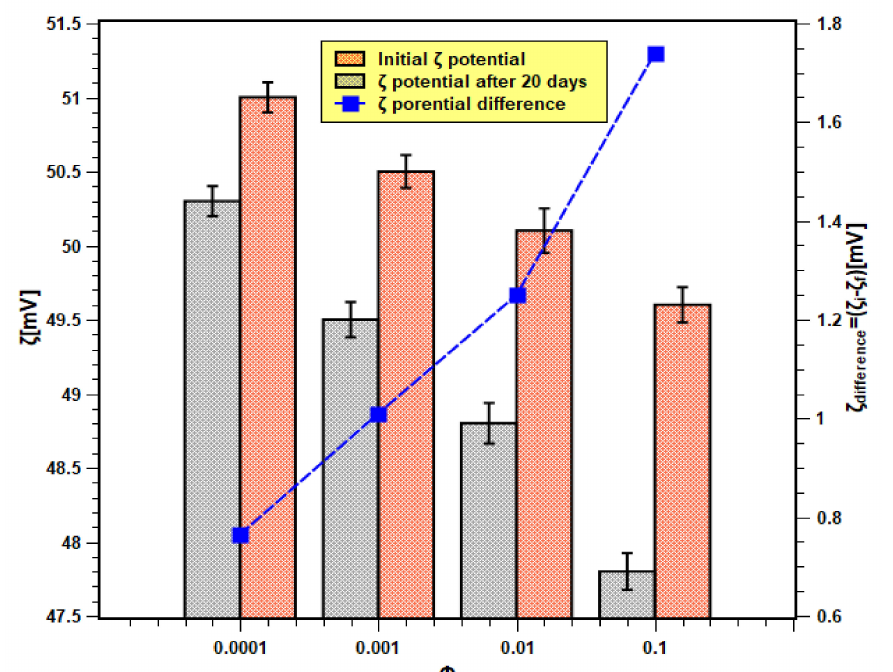
Figure 8. Zeta potential analysis results of